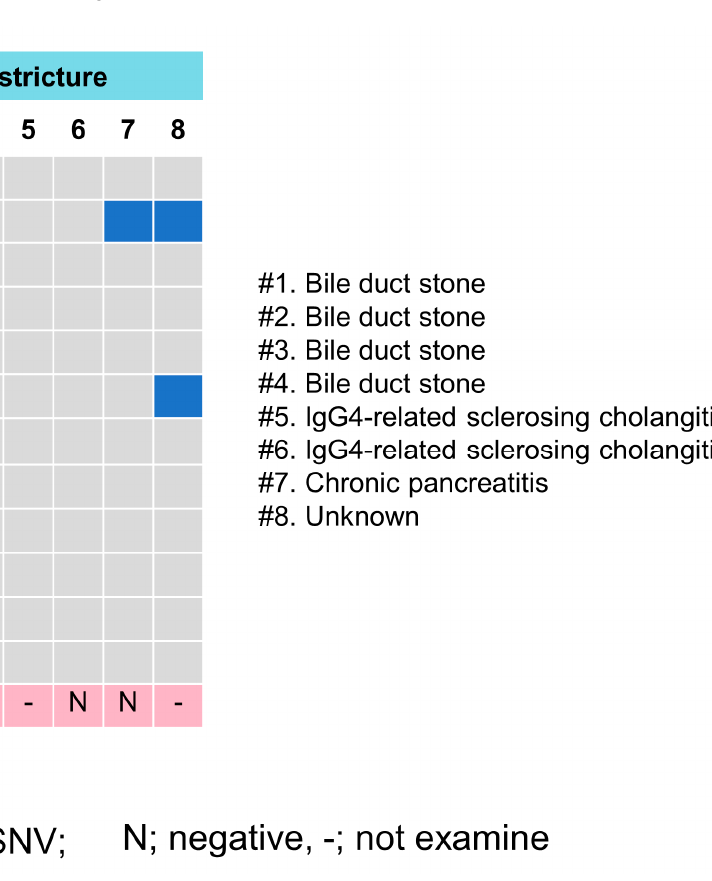
Figure 4. Pathogenic gene alteration profile in bile cfDNA of the patients with pancreaticobiliary malignancy. Multiple genetic mutations were detected except for intrahepatic cholangiocarcinoma and gallbladder cancer. EHCC, extrahepatic cholangiocarcinoma; I, intrahepatic cholangiocarcinoma; G, gallbladder cancer; PDAC, pancreatic ductal adenocarcinoma; N, negative; A, adenocarcinoma; -, not examined; SNV, single nucleotide variance.